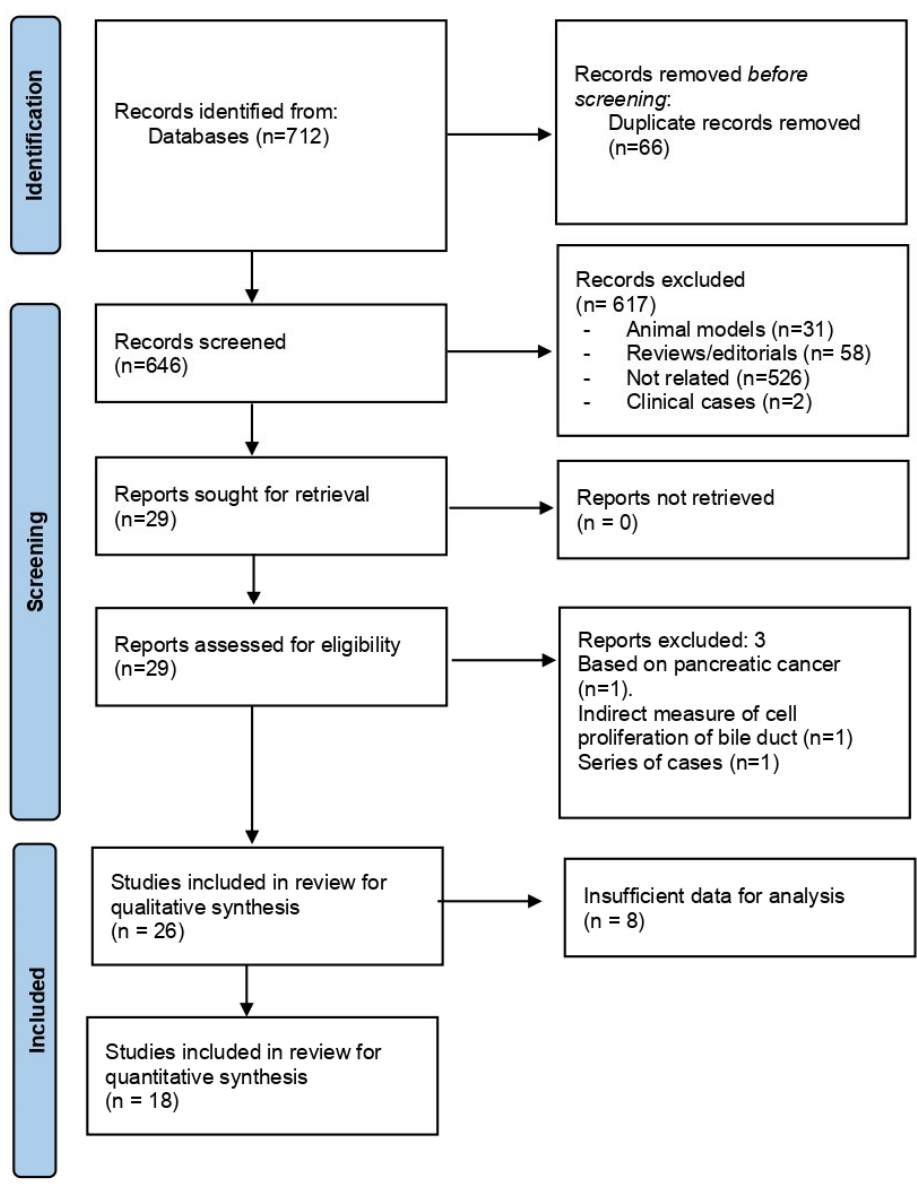
Figure 1. Flow diagram of the literature search and study selection.